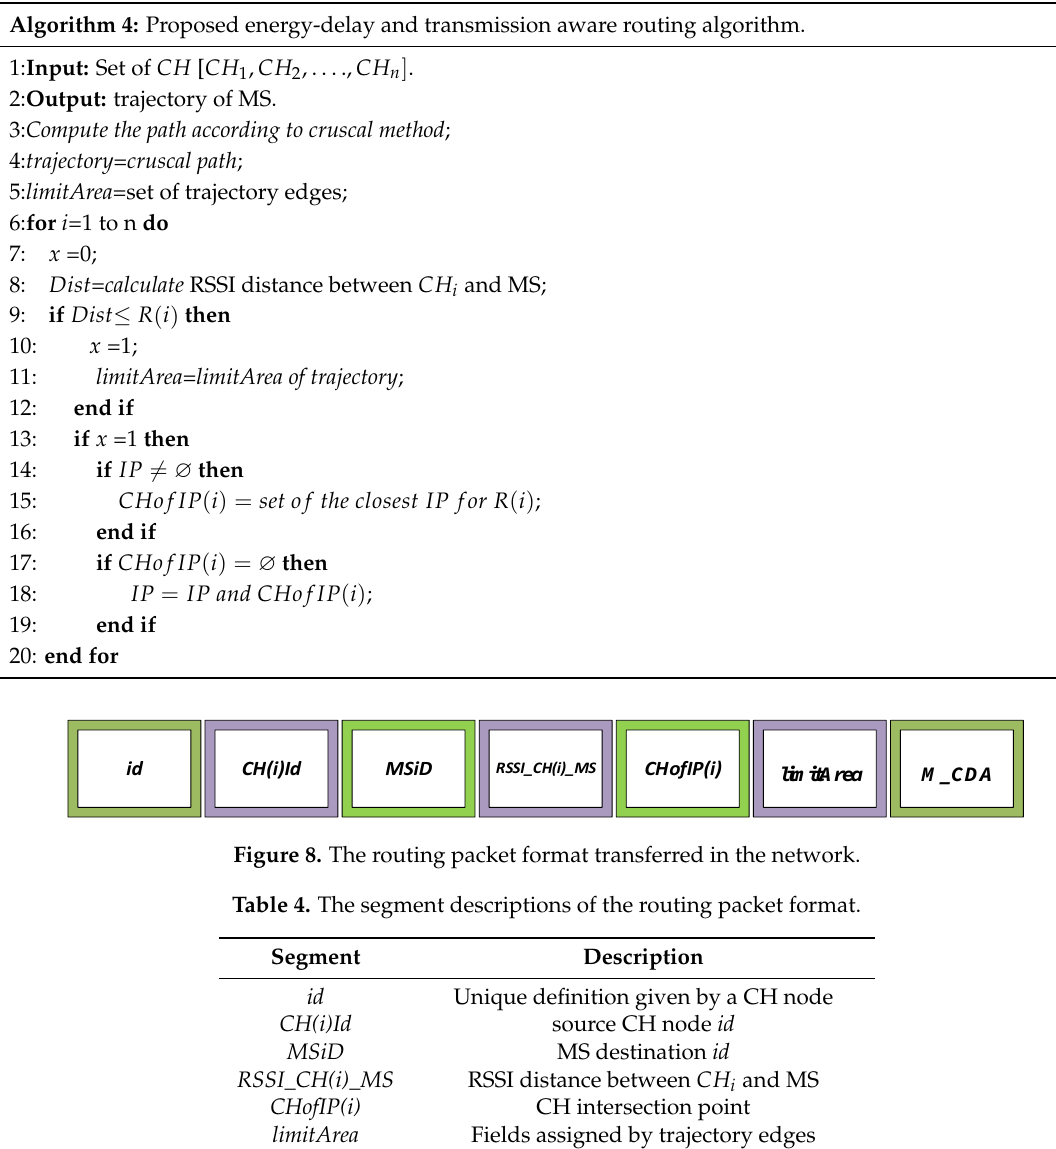
Algorithm 4: Proposed energy-delay and transmission aware routing algorithm.